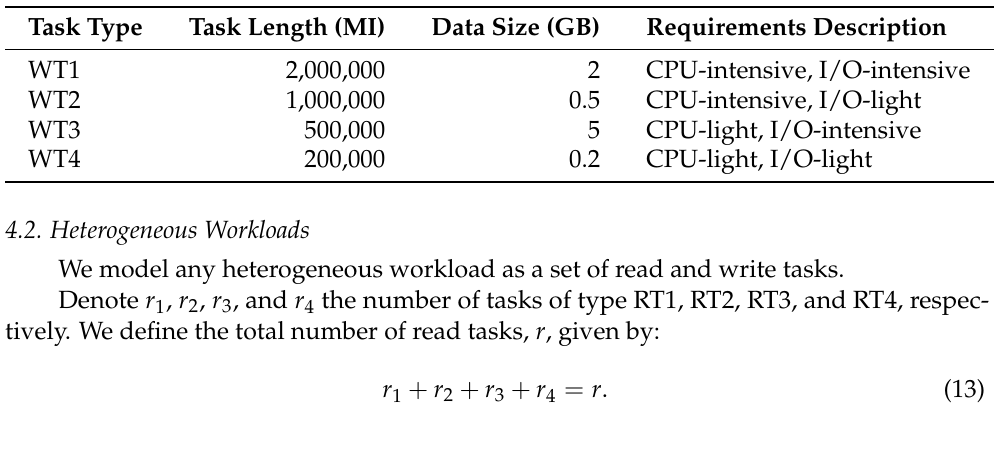
Table 2. Types of write tasks and their processing